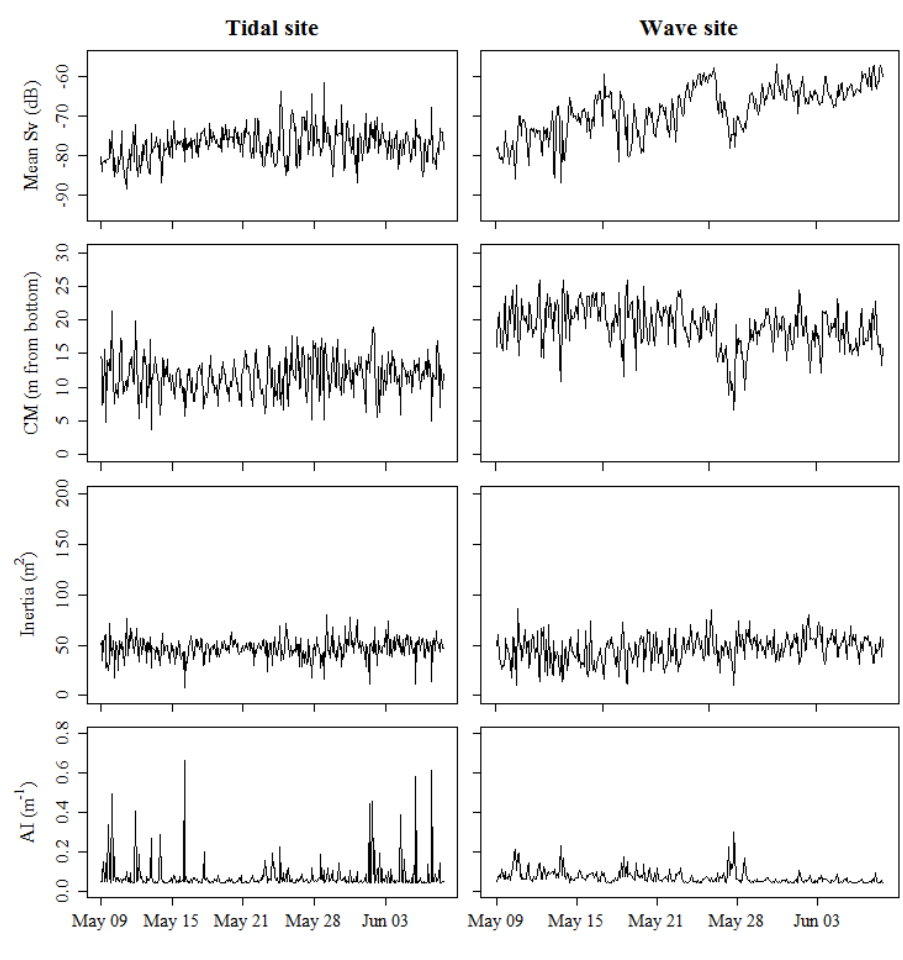
Fig. 2. Time series (N=362) of mean volume backscattered energy (mean Sv), center of mass (CM), inertia, and aggregation index (AI) from a tidal energy pilot site located in Admiralty Inlet (WA) (left panel) and a wave energy pilot site located off the coast of Newport (OR) (right